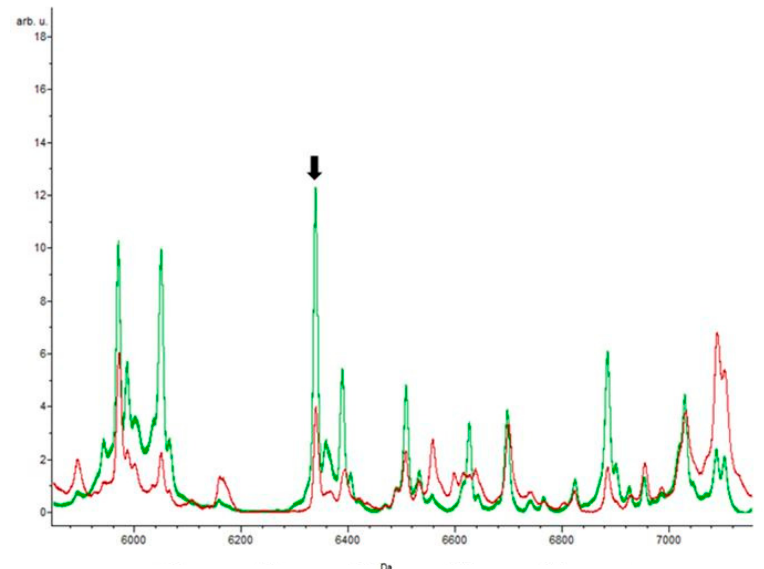
Figure 5. The red spectrum represents the control, and the green spectrum was obtained by the action of ciprofloxacin. The arrow shows the peak at m/z 4652.66 with greater intensity in the presence of the antibiotic. Among the 27 specific peaks detected in the isolates resistant to ampicillin, only the peak with mass m/z 6338 was identified by the three classification algorithms, with an area under the curve (AUC) value of 0.89. This peak was also identified in erythromycin-resistant isolates. In contrast, three other peaks, m/z 2361.38, m/z 3304.92, and m/z 7240.29, proved to be exclusive to these isolates, which means they are potential biomarkers of ampicillin resistance.